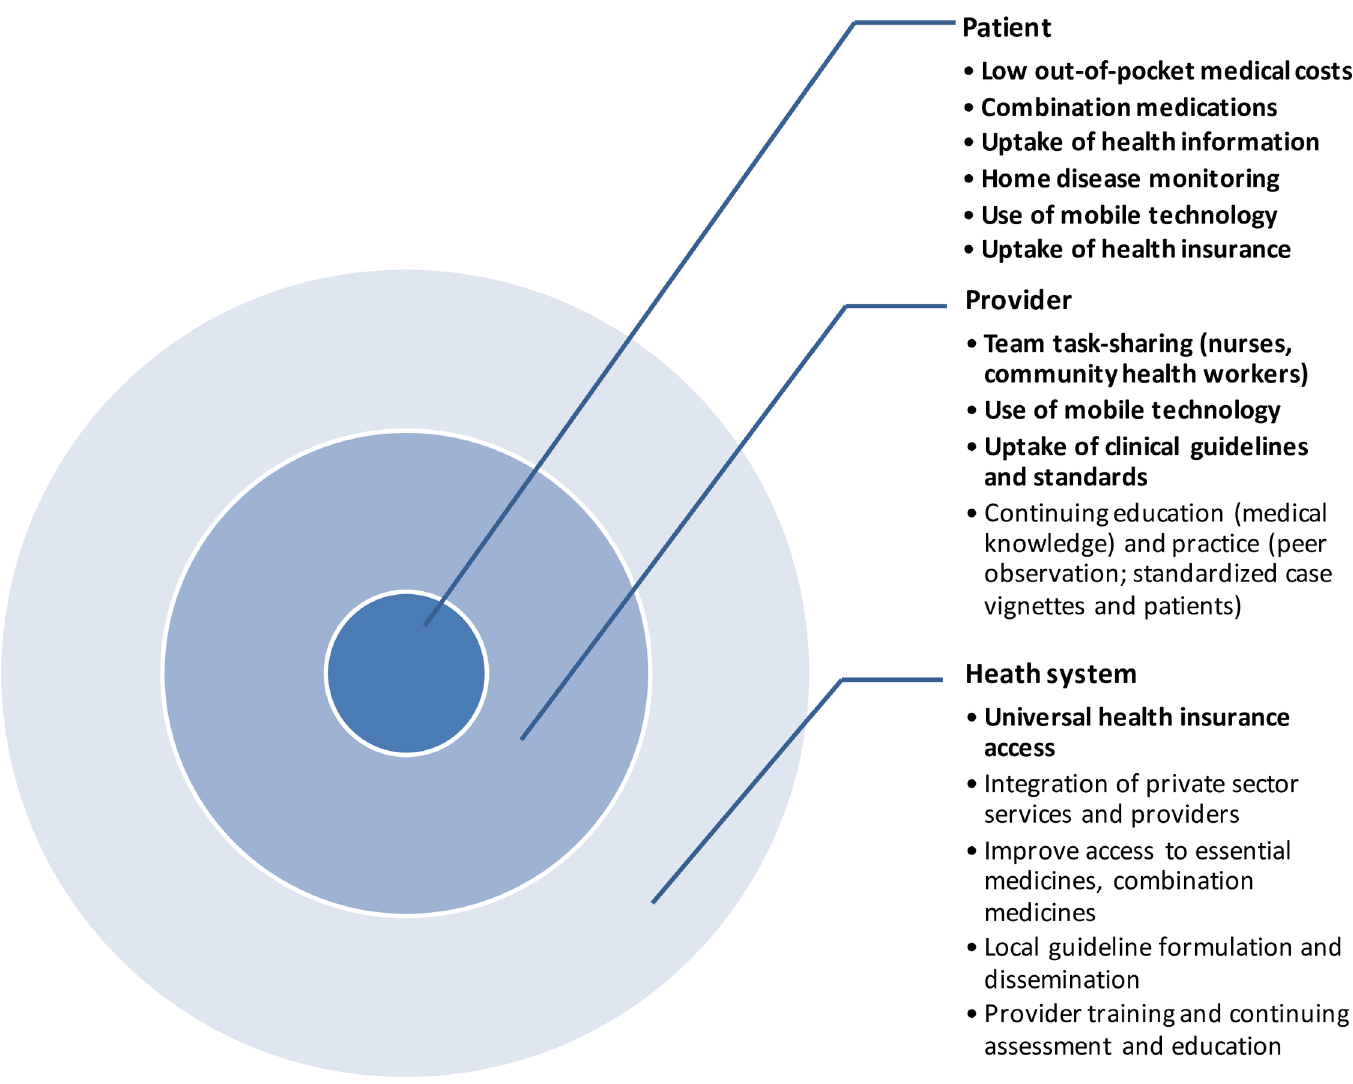
Fig 4. Examples of chronic phase CVD quality improvement interventions identified in the DCP3 systematic review. Types of interventions targeting three levels of chronic phase CVD prevention and management. Bullets in bold are supported by evidence from the review. Bullet without bold type indicate that no supporting evidence was found in the review and are potential areas for further